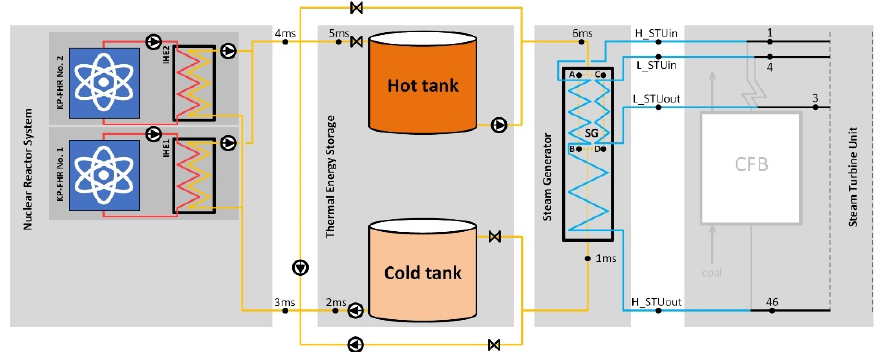
Figure 6. Integration diagram of 2 nuclear reactors and TES system with the steam turbine unit (Case TES_2NR).